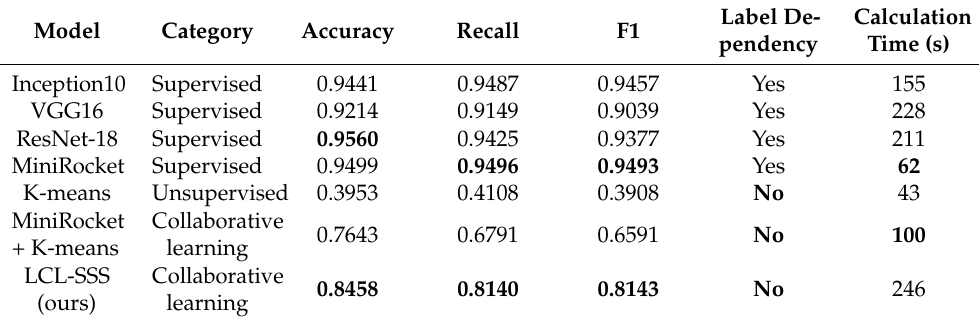
Table 2. Experimental results of different